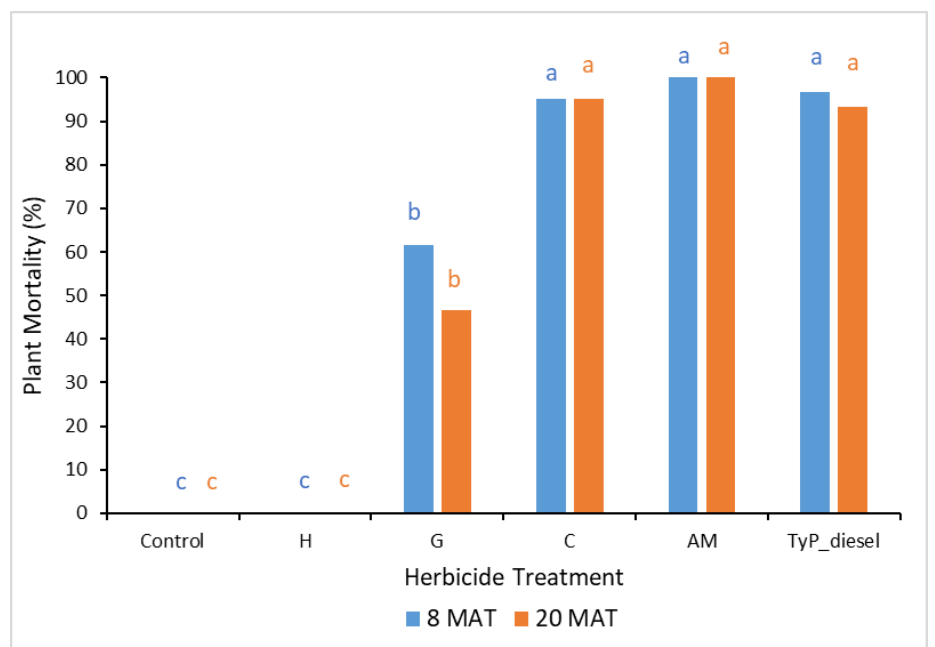
Figure 10. Average stem regrowth of mimosa bush 8 and 20 MAT following cut stump herbicide application in trial 4. H, hexazinone; G, glyphosate; AM, aminopyralid + metsulfuron-methyl; C, clopyralid; TyP_diesel, triclopyr + picloram mixed with diesel. For each monitoring time, columns with different letters indicate significant difference by Tukey’s test with 95% confidence.